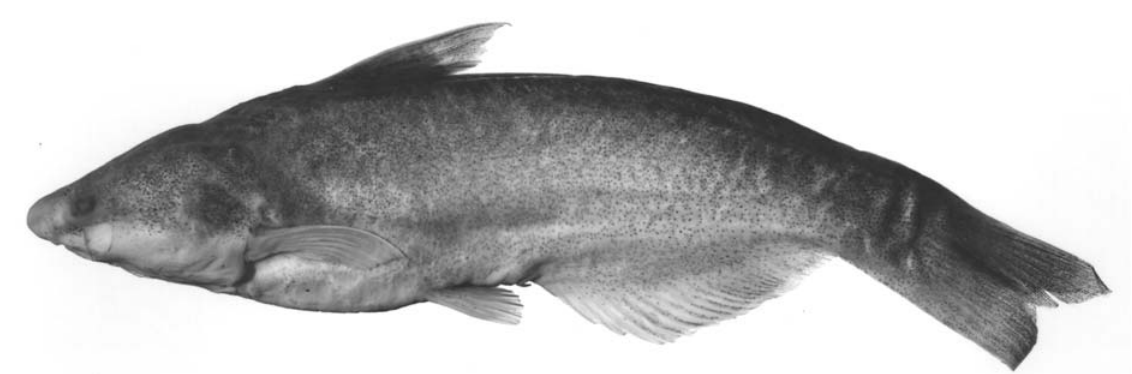
Fig. 54. Paracetopsis atahualpa , new species, holotype, MUSM 11560, 128 mm SL; Peru, Tumbes, río Tumbes, Cabo Inga (3°58’00"S, 80°24’59"W).